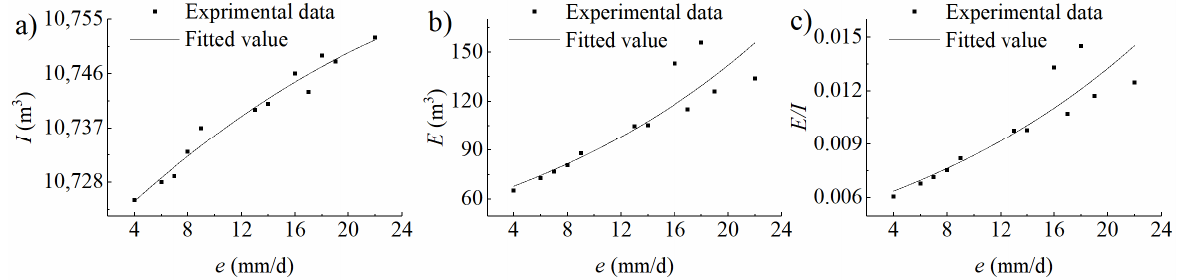
Figure 4. The variations with an increment in e. (( a ) variation of I; ( b ) variation of E; ( c ) variation of E/I.).